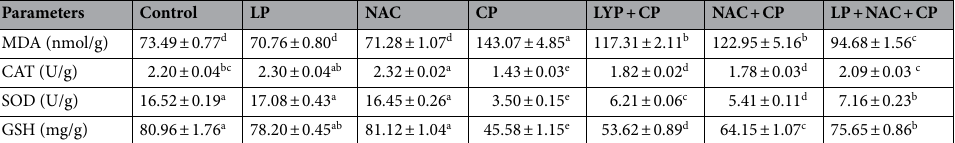
Table 3. Effects of LP, NAC, and/or CP on antioxidant parameters in renal tissues. Data are expressed as the mean ± SE (n = 7). Different superscript letters in the same row indicate statistical significance at P ≤ 0.05. Cisplatin (CP) at a single dose of 7.5 mg/kg (IP);; Lycopene (LP) at dose of 10 mg/kg ;N-acetycysteine (NAC) at a dose of 150 mg/kg. Malondialdehyde (MDA); catalase (CAT); superoxide dismutase (SOD); reduced glutathione